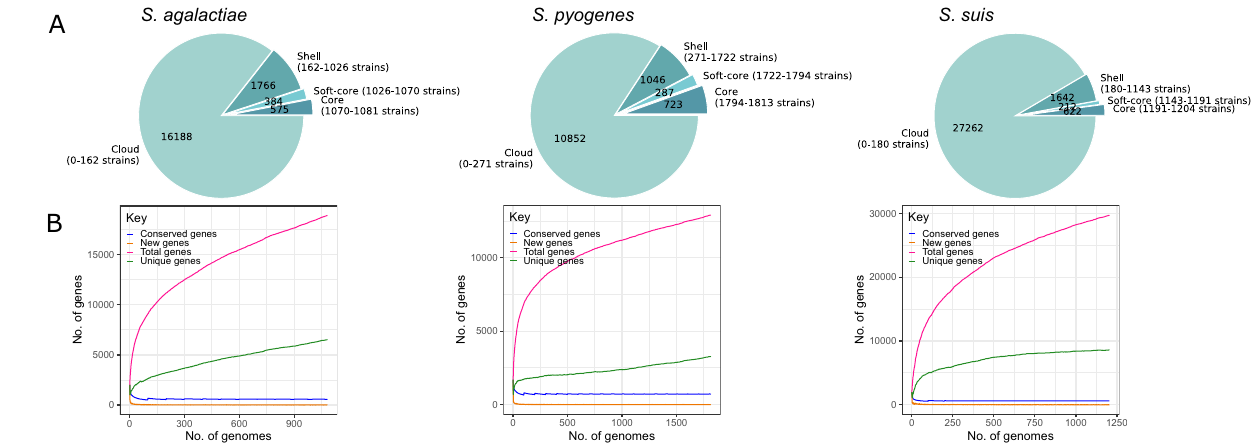
Figure 1. Pan-genome characteristics of each Streptococcus species calculated using Roary. ( a ) Pie charts showing the distribution of core, soft core, shell and cloud genes. ( b ) Accumulation curves showing the size of the pan-genome, i.e., the totality of unique genes present in each species (pink line), the size of the core genome, i.e., genes that are present in at least 99% of the strains (blue line), the number of unique genes, i.e., genes unique to an individual strain (green line), and new genes, i.e., genes not found in the previously compared genomes (orange line) in relation to numbers of genomes being compared. Detailed results of Roary are shown in Supplementary Table